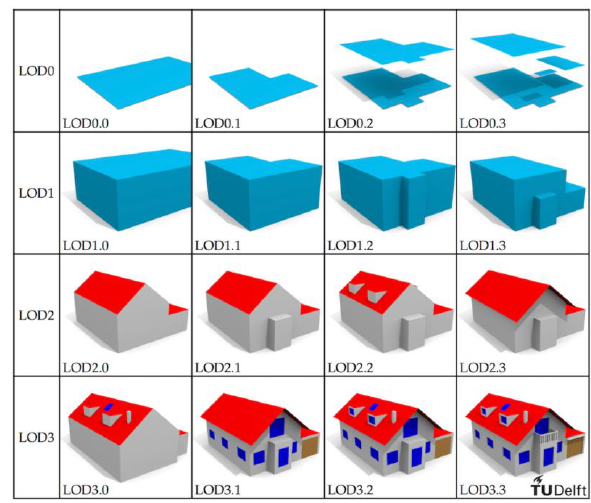
Figure 9. Targeted levels of detatil (Biljecki et al ., 2016).